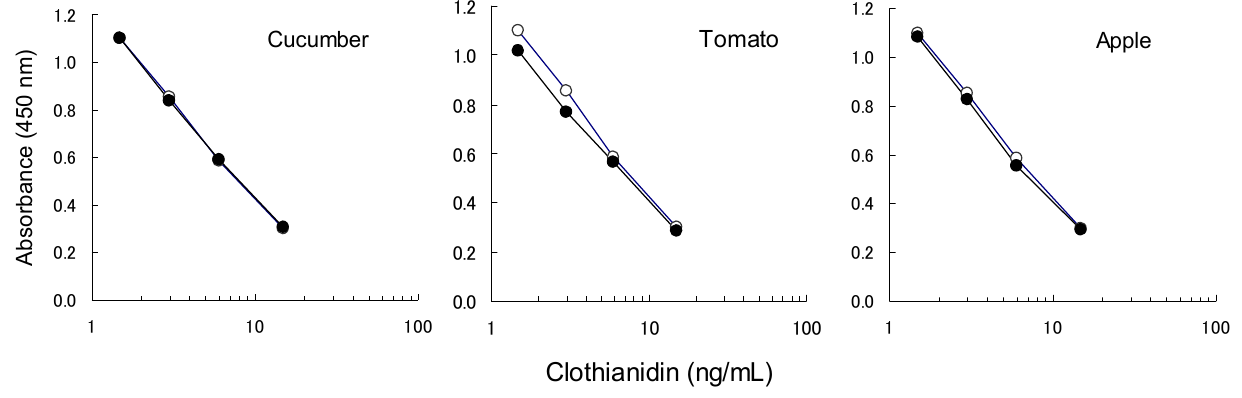
Figure 3. Influence of matrix substances from garden crops in the dc-ELISA. Line with white circle ( ○ ) shows inhibition curve between the IC standards in 10% methanol. Line with black circle ( ● ) shows the corresponding inhibition curve for clothianidin in each garden crop extract diluted to 10% methanol.